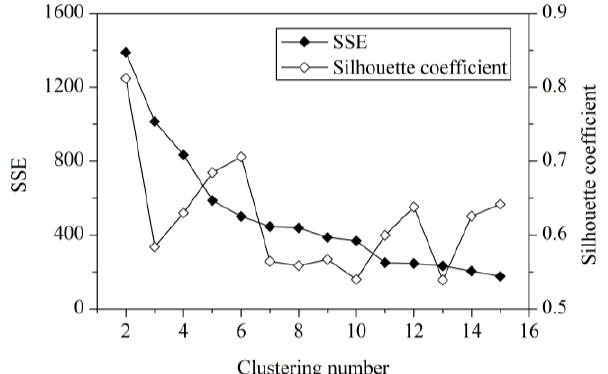
Figure 4. SSE and average silhouette coefficient versus number of